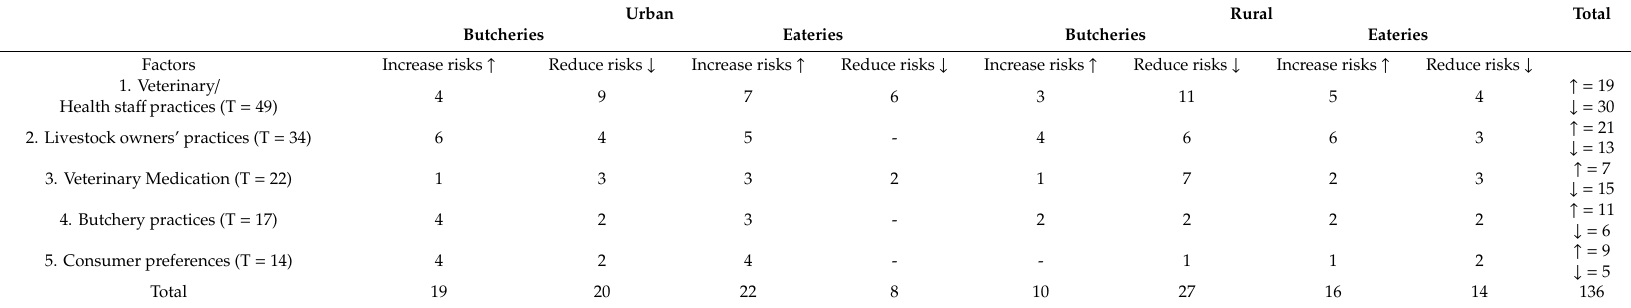
Table 3. Risk assessment of factors that operators of butcheries and eateries believe a ff ect future meat safety risks and the number of times they are cited across business types and locations 1)